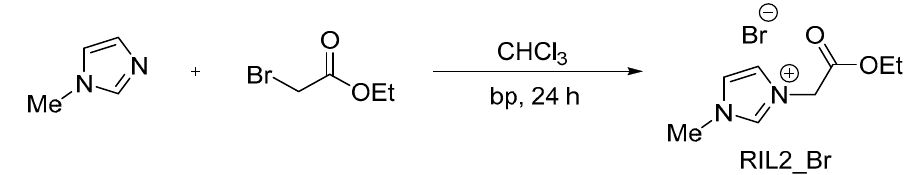
Figure 2. Scheme of 1-(2-ethoxy-2-oxoethyl)-3-methylimidazolium bromide (RIL2_Br) synthesis. FTIR-ATR ν max (RIL1_Br): 3070, 2993, 1759, 1556, 1221, 1263, 1471, 1444, 1182, 839, 750 cm FTIR-ATR ν max (RIL2_Br): 3425, 3082, 2982, 1745, 1572, 1225, 1470, 1439, 1174, 876, 766 cm